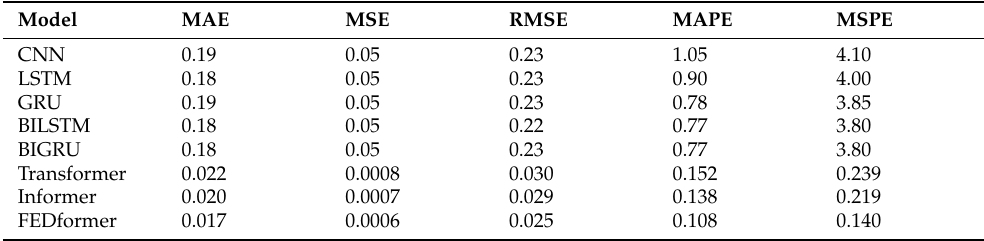
Table 4. Comparative experimental results of model performance for predicting quality changes during wheat